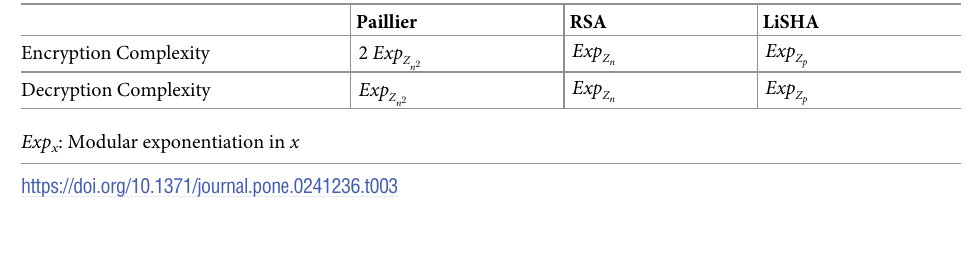
Table 3. Computational complexities of the Paillier, RSA and LiSHA